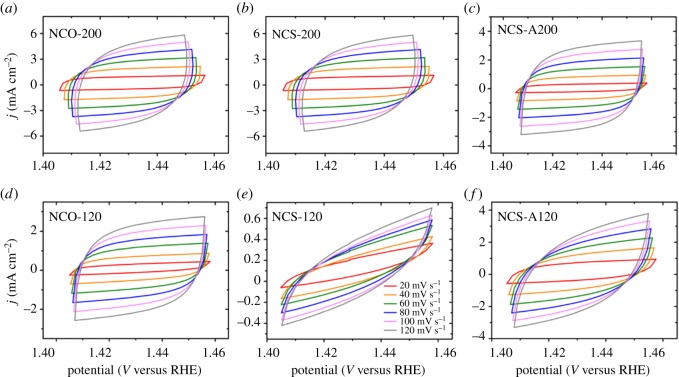
CV measurements in a voltage range of 1.4–1.46 VRHE at scan rates 20, 40, 60, 80, 100 and 120 mV s−1 of (a) NCO-200, (b) NCS-200, (c) NCS-A200, (d) NCO-120, (e) NCS-120 and (f) NCS-A120.